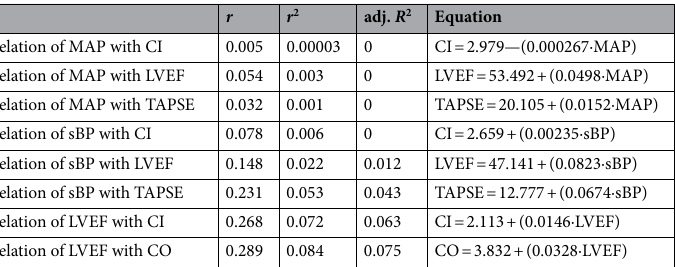
Table 2. Correlations between systolic and mean arterial pressures and hemodynamic parameters determined by echocardiography. MAP mean arterial pressure, CI cardiac index [L·min −1 ·m −2 ], LVEF left ventricular ejection fraction [%], TAPSE tricuspid annular plane systolic excursion [mm], sBP systolic blood pressure [mmHg], CO cardiac output [L·min −1 ], r correlation coefficient, r 2 coefficient of determination, adj. R 2 adjusted R-squared